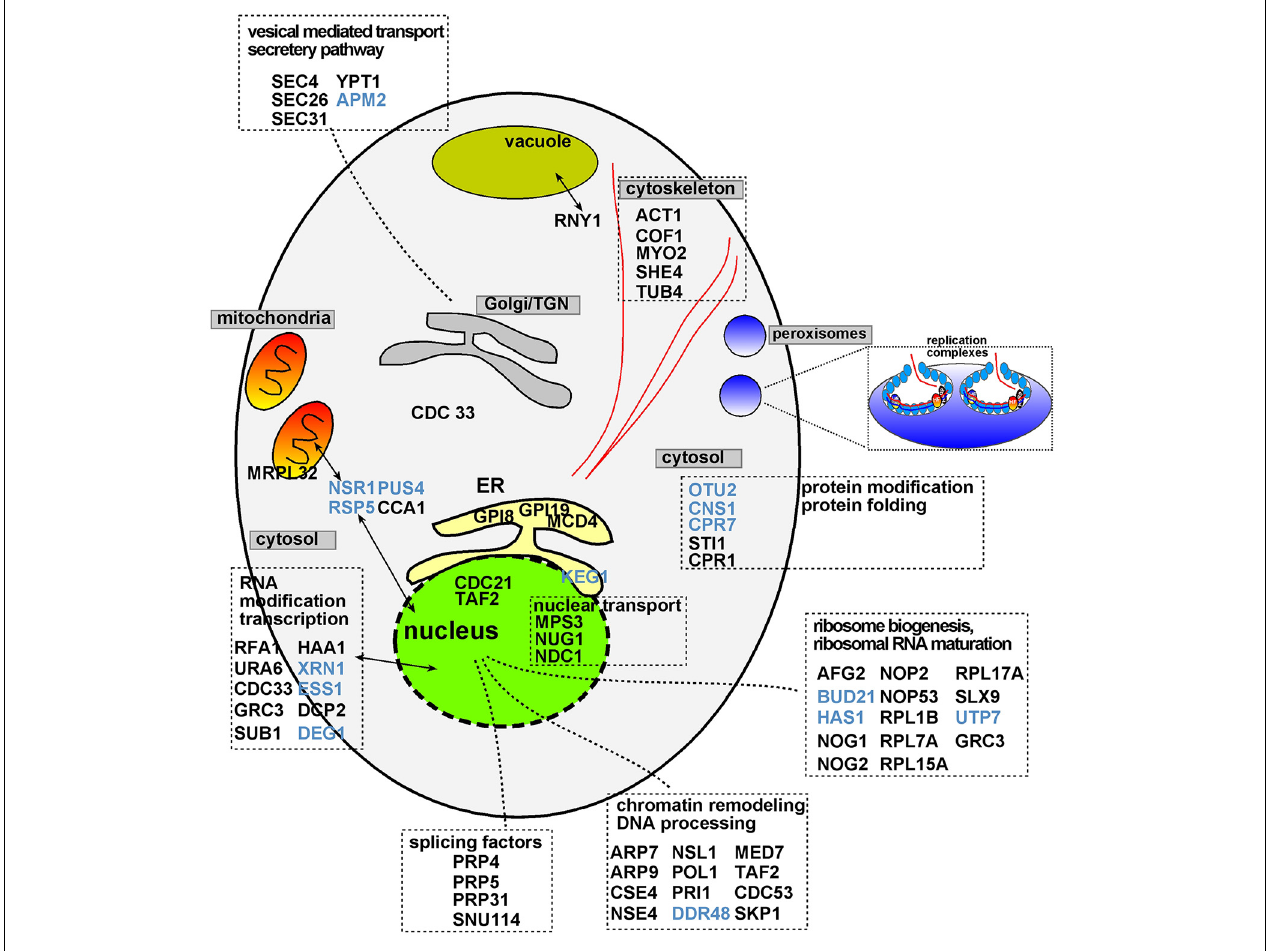
FIGURE 1 | Functions and subcellular localizations of cell-intrinsic restriction factors inhibiting tombusvirus replication in yeast. Those cellular restriction factors that interact with the tombusvirus replication proteins or the viral RNA are shown in blue. Proteins present in two different